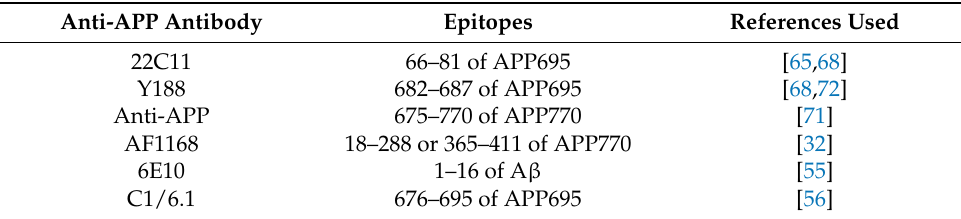
Table 1. Summarized table for anti-APP antibodies used in Section 5. The antibodies are shown in the order in which they appear in Section